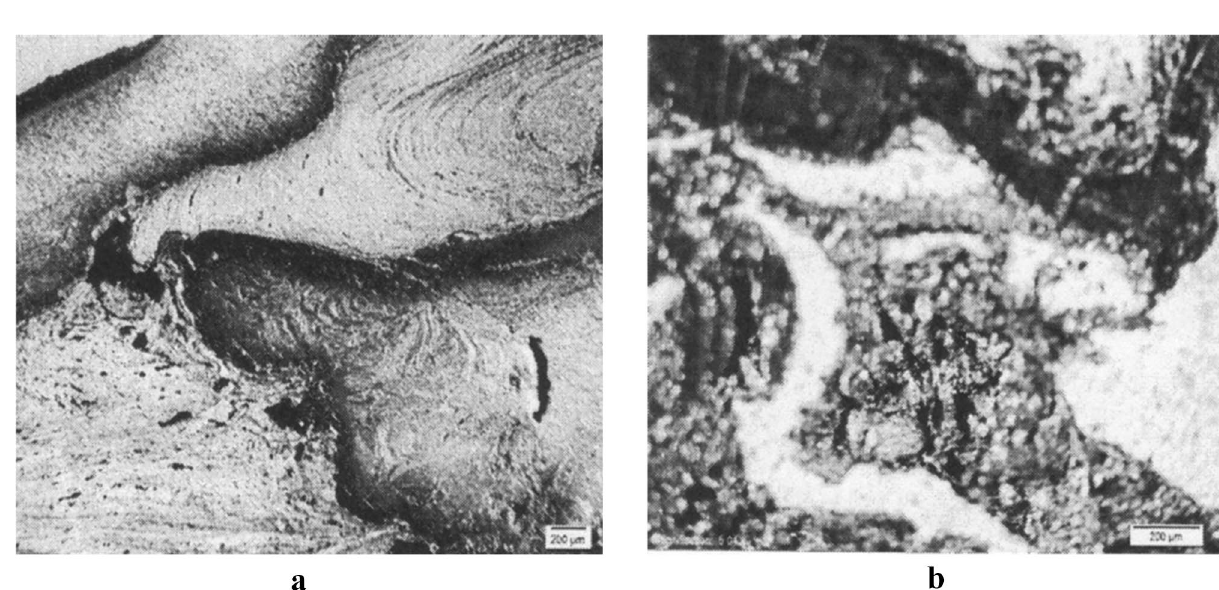
Figure 16. Macroscopic images of the weld cross-section of ( a ) b17 and ( b ) c12